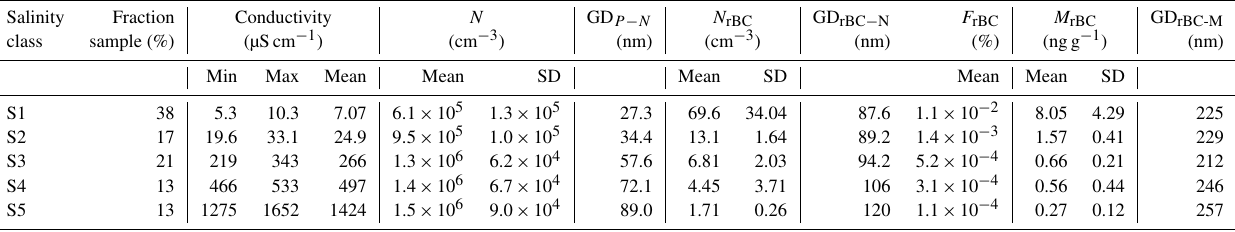
Table 1. Properties of snow samples grouped in conductivity classes. Conductivity of melted samples measured between 20 and 25 ◦ C. Total aerosolized particles measured in the mobility diameter range 14–685nm show the number concentration ( N ) and geometric mean of the number size distribution (GD P − N ). rBC particles are measured between 60 and 1000nm of D rBC , showing the number concentration ( N rBC ), mass mixing ratio ( M rBC ), geometric mean of the number (GD rBC-N ) and mass (GD rBC-M ) size distribution. The number fraction of rBC particles ( F rBC ) is also given.